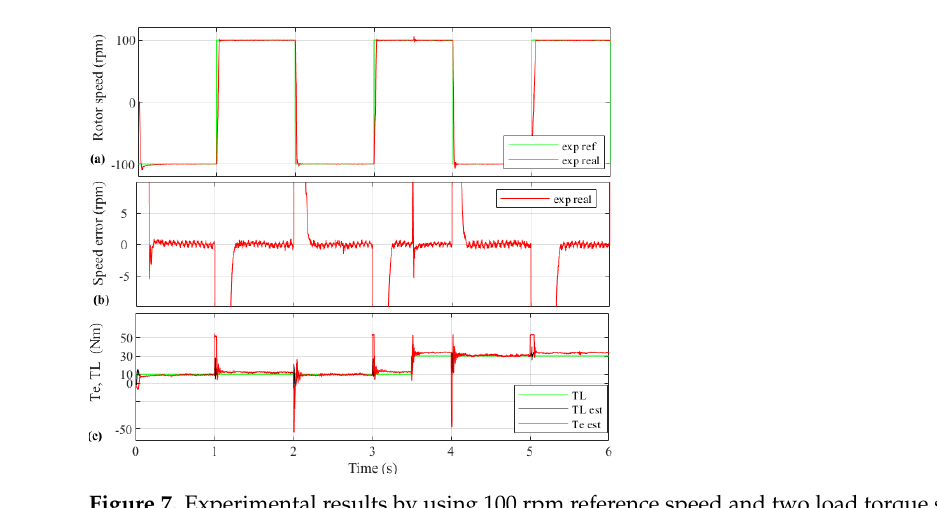
Figure 7. Experimental results by using 100 rpm reference speed and two load torque steps changes (D2 design): ( a ) Rotor speed; ( b ) Speed error and ( c ) T e , T L .